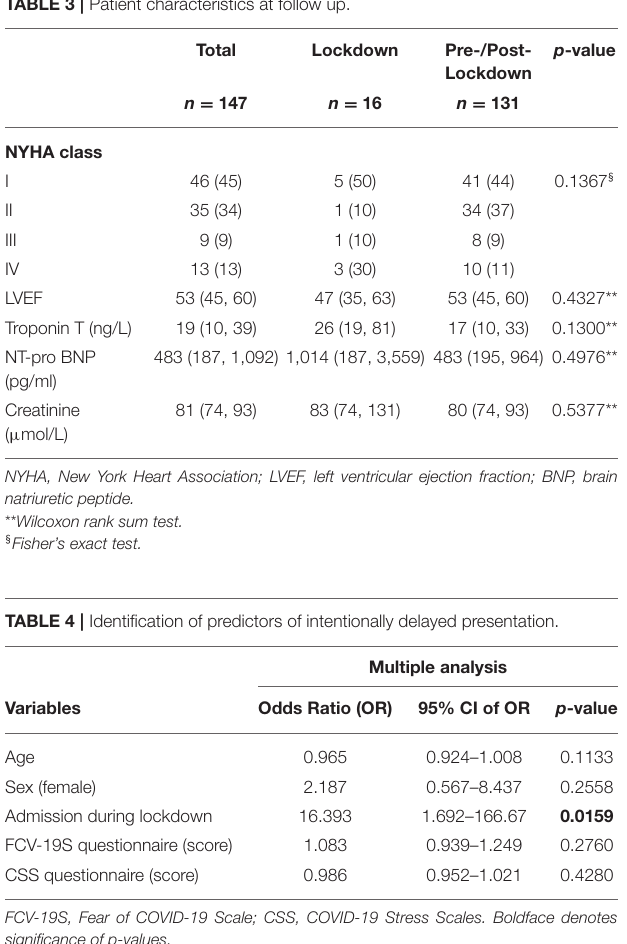
TABLE 3 | Patient characteristics at follow up.